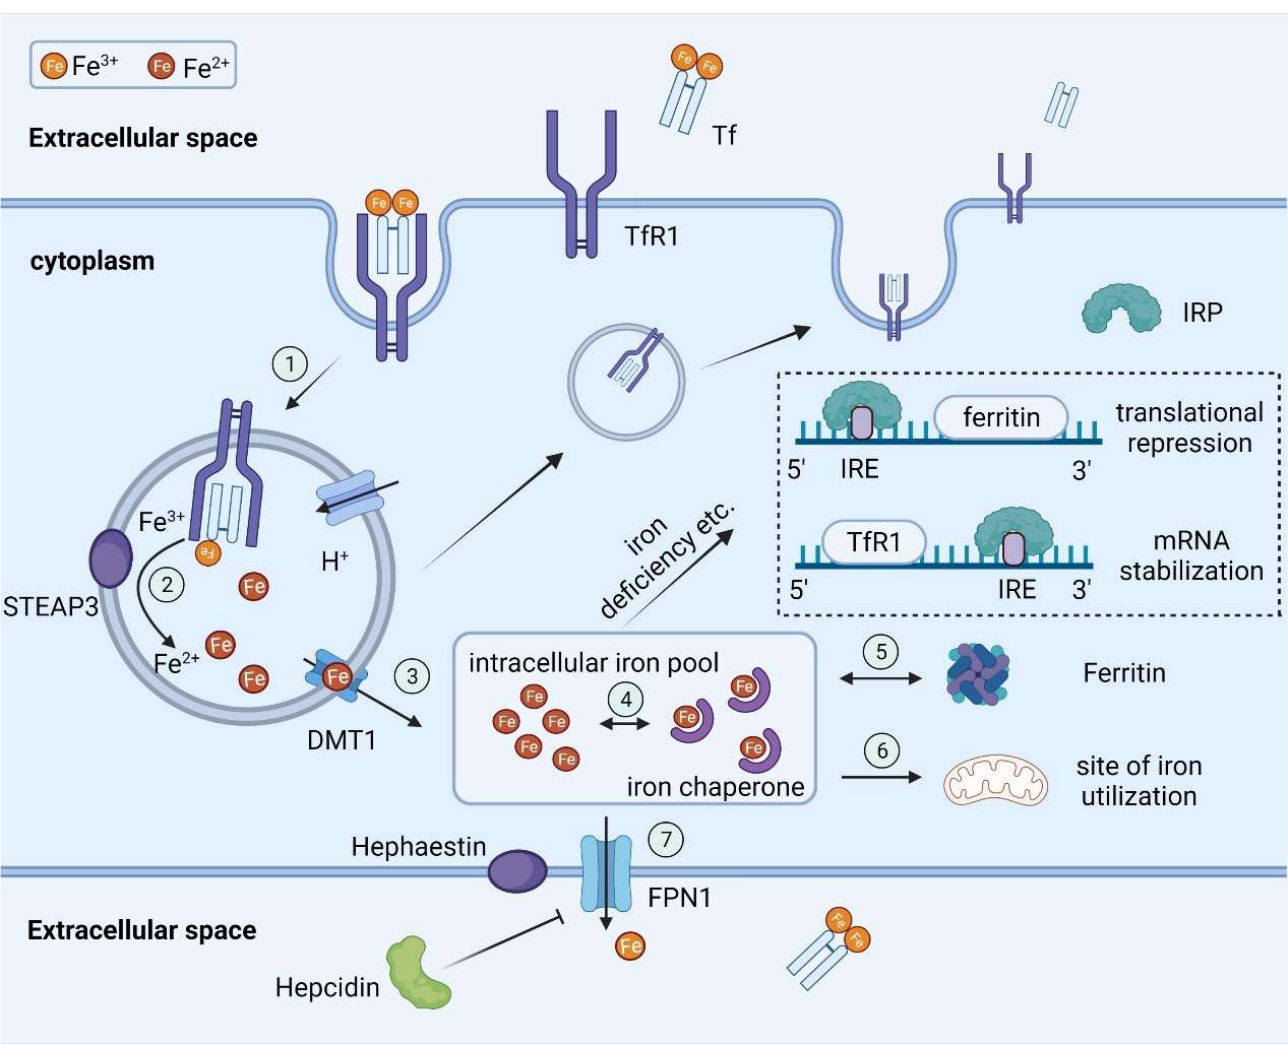
Figure 1. Cellular iron transport and regulation under physiological conditions. Iron transport: Plasma diferric Tf binds with TfR1 expressed on the membrane of cells. The Tf–TfR1 complex is internalized by receptor-mediated endocytosis ( 1 ). Within the highly acidified endosome, iron is released from Tf after the reduction of ferric iron takes place with the help of ferrireductase STEAP3 ( 2 ). Iron crosses the endosomal membrane into the cytoplasm via DMT1 ( 3 ). Iron chaperones exist in the cytoplasm to move iron within the cell ( 4 ). Intracellular iron can either be sequestered with ferritin ( 5 ) or transported directly to the sites of need ( 6 ). Upon mobilization, iron can efficiently detach from ferritin and be exported by FPN ( 7 ). Iron regulation: Hepcidin blocks cellular iron egress by binding with FPN and leads to its degradation. Intracellular iron level can be regulated by the IRP-IRE system. When cellular iron concentration is low, IRPs would bind to the 5′ UTR of ferritin mRNA and the 3′ UTR of TfR1 mRNA, which blocks the translation of the former and protects the latter from degradation. Abbreviations : Tf, transferrin; TfR1, transferrin receptor 1; STEAP3, six-transmembrane epithelial antigen of the prostate 3; DMT1, divalent metal transporter 1; FPN, ferroportin; IRP, iron regulatory protein; IRE, iron-responsive element.